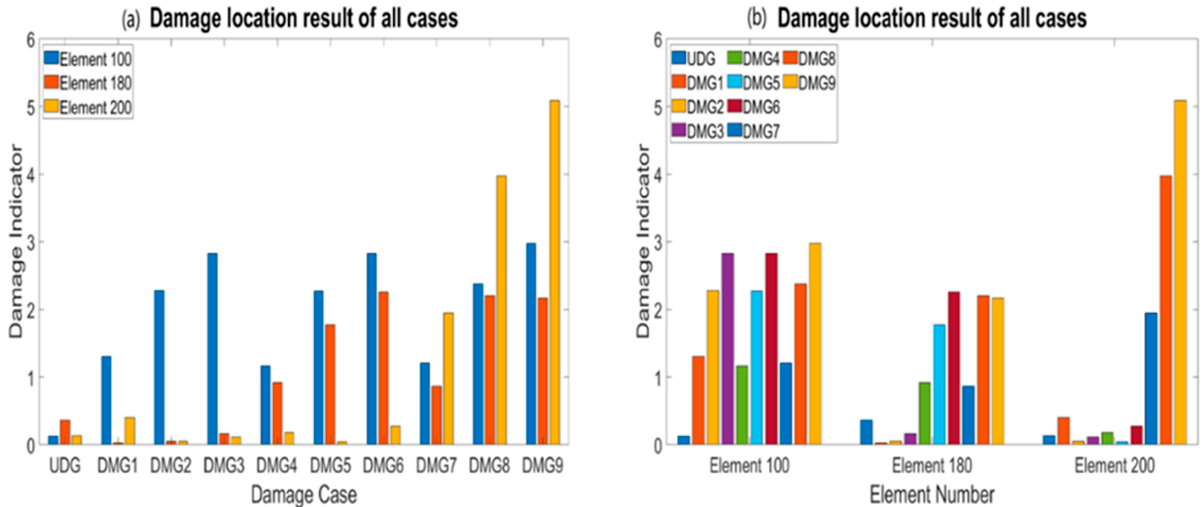
Figure 13. Damage recognition results for different damage cases with 12% white noise: ( a ) undam- aged cases and damage cases (DMG1-DMG9); and ( b ) comparison of all cases on different elements.